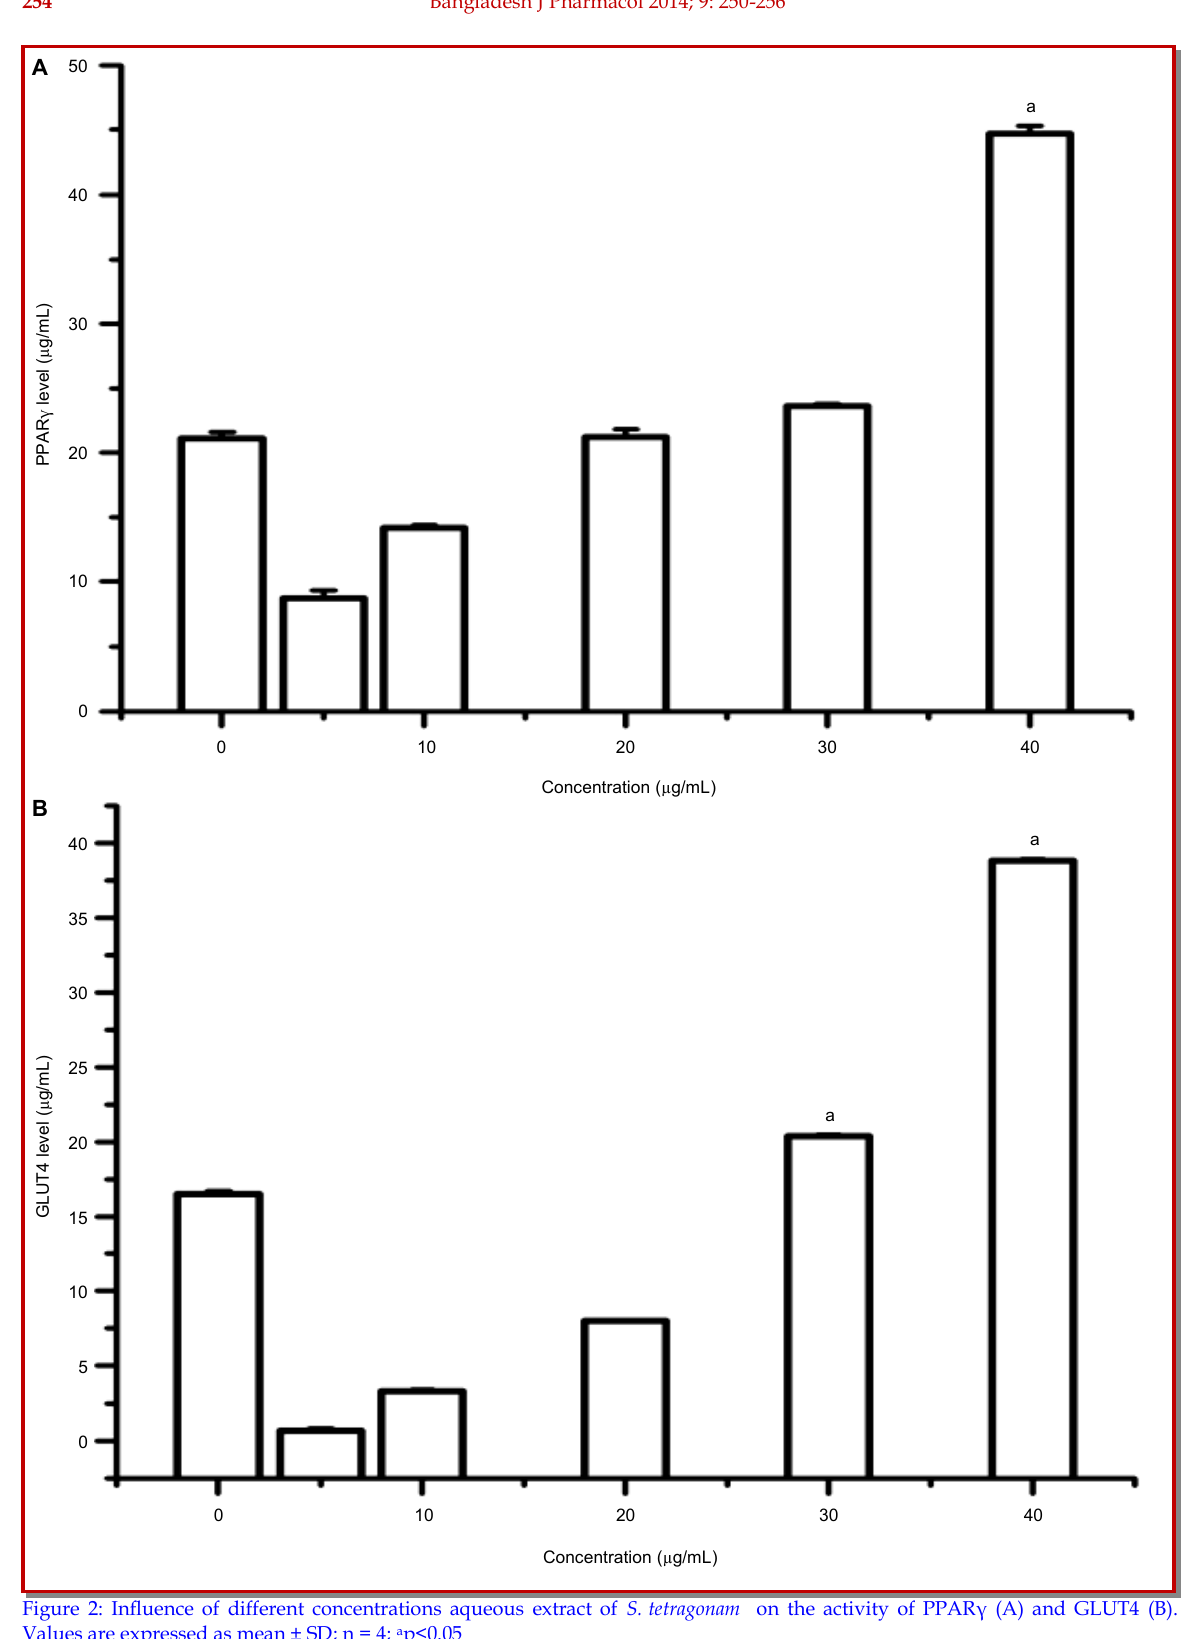
Figure 2: Influence of different concentrations aqueous extract of S. tetragonam on the activity of PPAR γ ( A) and GLUT4 (B). Values are expressed as mean ± SD; n = 4; a